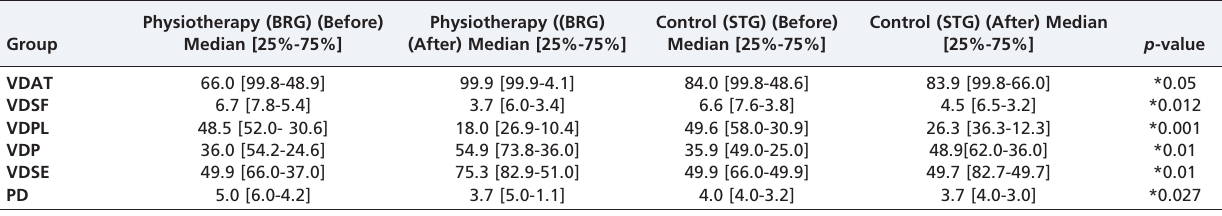
Table 2 - The evolution of parameters expressed as median values (25%-75%). At the start of the study, both groups presented with equally compromised health-related quality of life scores and the same levels of panic and asthma symptoms. Final measurements indicated improvements in all domains. Variations in the domains of quality of life and symptoms in asthmatic patients.